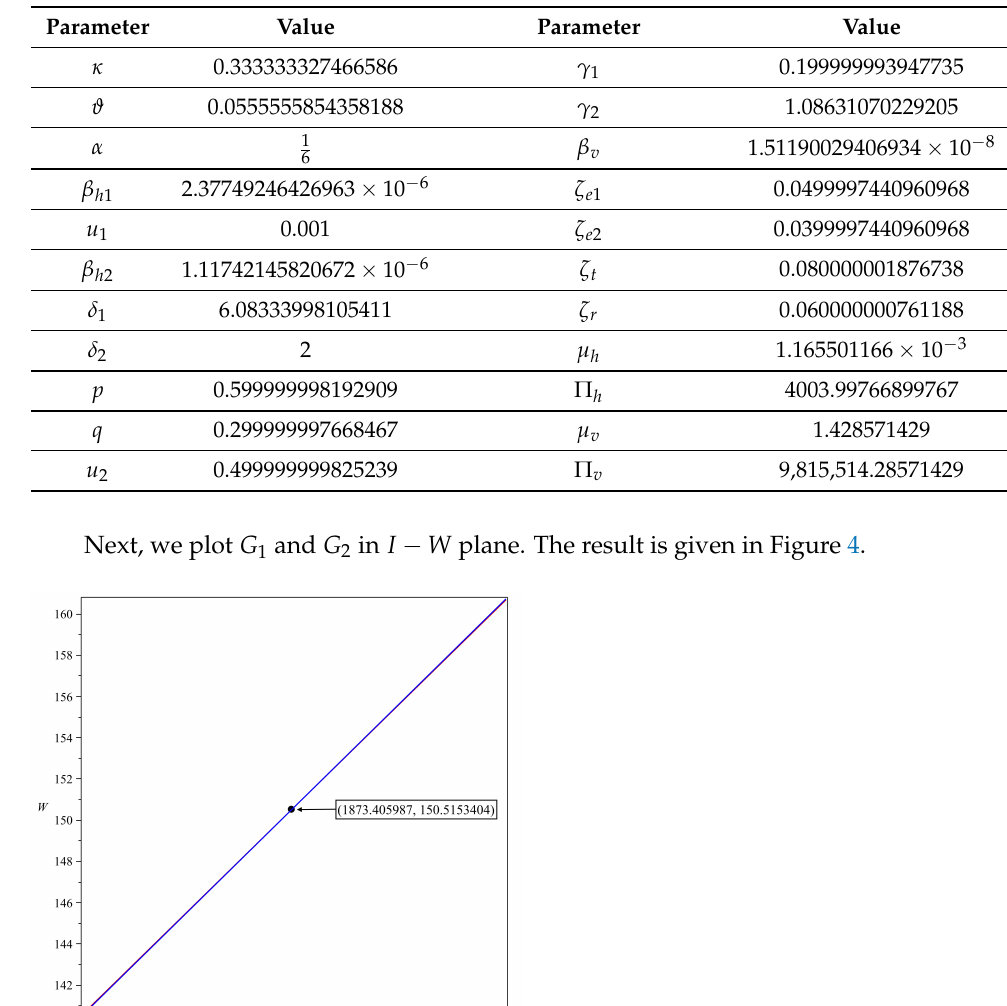
Table 3. Parameter values to show existence of E † .